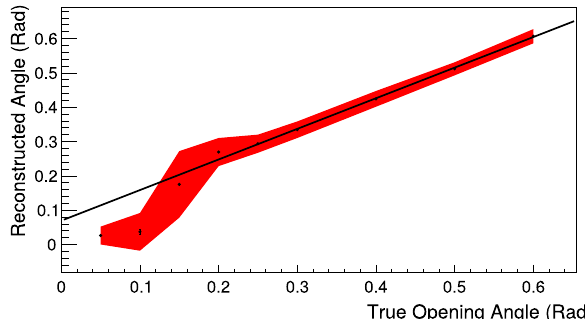
Fig. 31 Example opening angle reconstruction and resolution for an initial cluster and track building algorithm using 1GeV electrons pro- duced from a two-body decay at the front of the detector